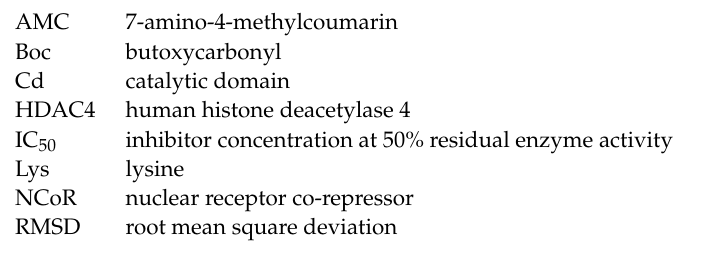
Regions of largest structural shifts for the transition from closed to open conformation of HDAC4; Figure S5: Overlay of HDAC4c and HDAC4o showing the amino acids that are mutated; Figure S6: The distance between C β -atoms is plotted versus the number of the mutated amino acids; Figure S7: Cluster analysis of most active TZD analogs; Figure S8: Overlap of docking poses of TZD analogs to (A–C) HDAC4c and (D–F) HDAC4o; Table S1: SMILES Strings and IC50-values of all tested TZD ligands; Table S2: IC50-values in µ M for indicated TZD ligands towards cdHDAC4wt and corresponding mutants; Table S3: Open reading frame of cdHDAC4wt in pET14b for recombinant protein expression; Table S4: Mutant to cdHDAC4wt (WT) IC50